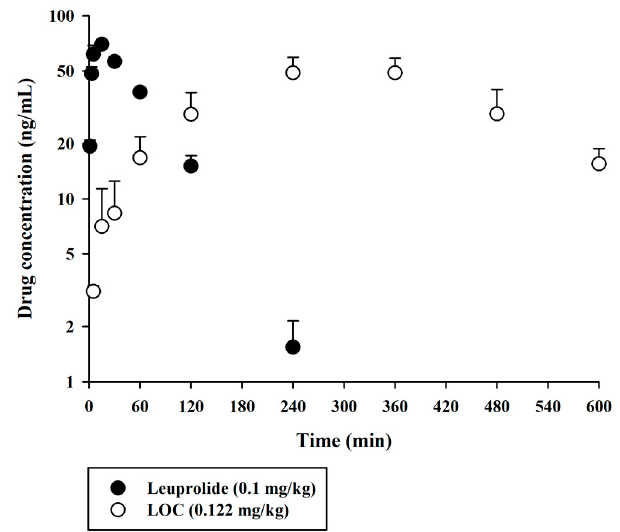
Figure 3. Arterial plasma concentration versus time profiles of leuprolide and the LOC following the subcutaneous administration of leuprolide and the LOC in rats. The closed and open circles and their error bars represent the mean and standard deviation values, respectively ( n = 4).